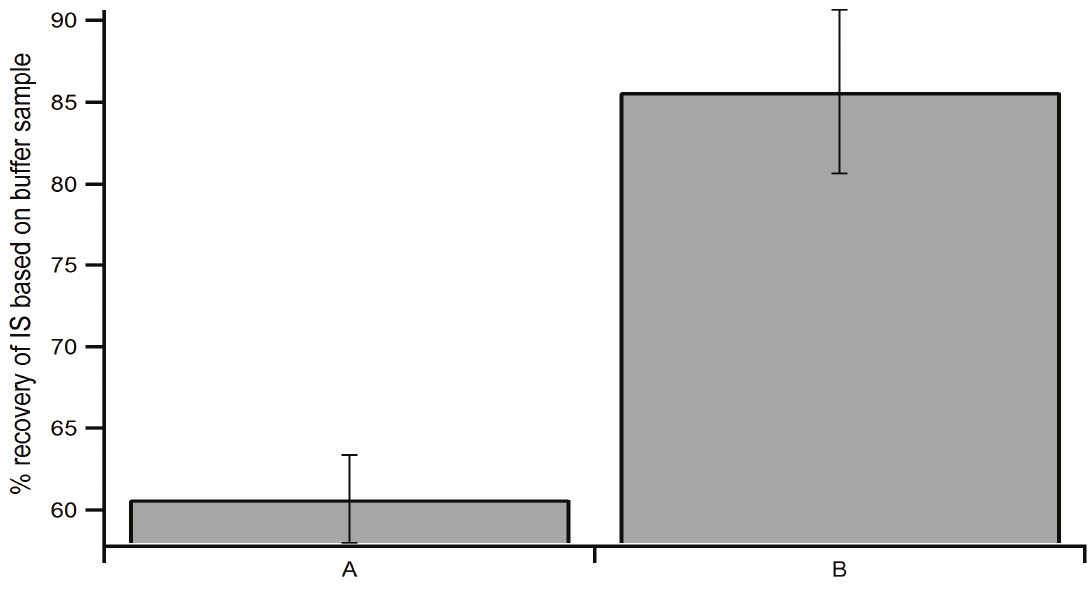
Figure 4. Percent recovery of IS signal in samples without and with high-speed centrifugation. Heat extractions were performed independently. ( A ) Sample was treated without high-speed centrifugation step; ( B ) sample was treated with the high-speed centrifugation step (Figure 2, step